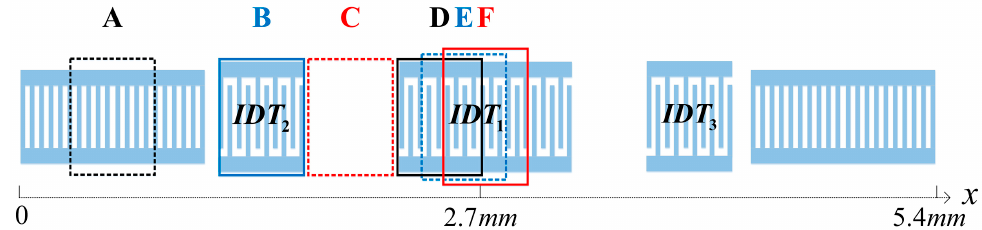
Figure 13. The schematic of mass deposited along the x -axis from A to F on the two-port SAW resonator.